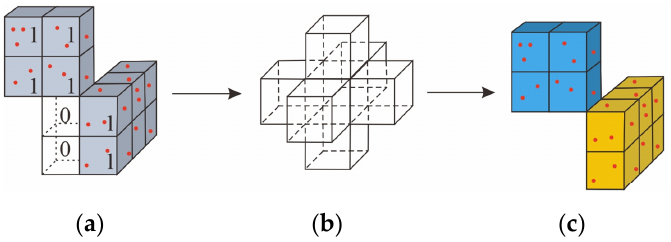
Figure 6. Process of the voxel connectivity analysis. ( a ) The voxels before segmentation. The voxels with no point are labeled as 0, while the voxels containing points are labeled as 1. ( b ) A six-connected model; ( c ) the result after the voxel connectivity analysis. Different object primitives are colored with different